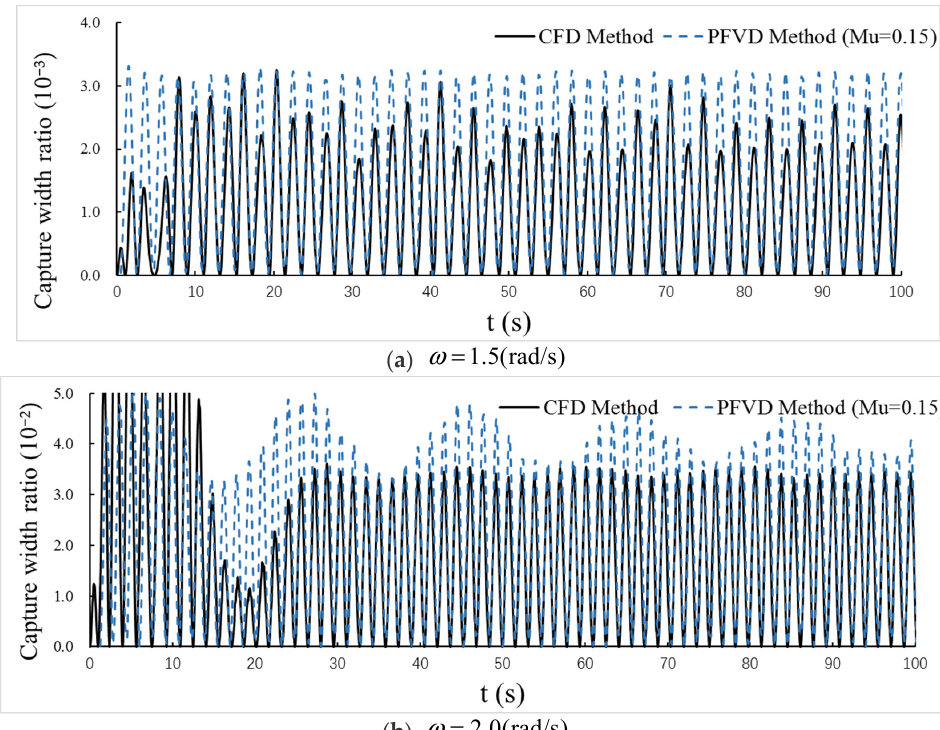
Figure 16. The capture width ratio of the MJWEC with different frequencies.